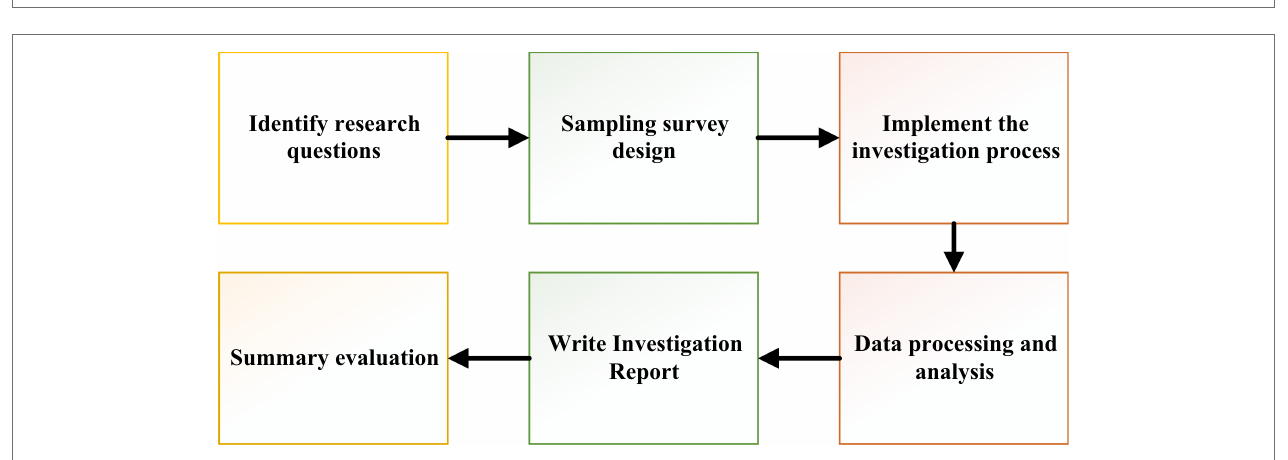
FIGURE 2 | The operation mode of innovation and entrepreneurship.